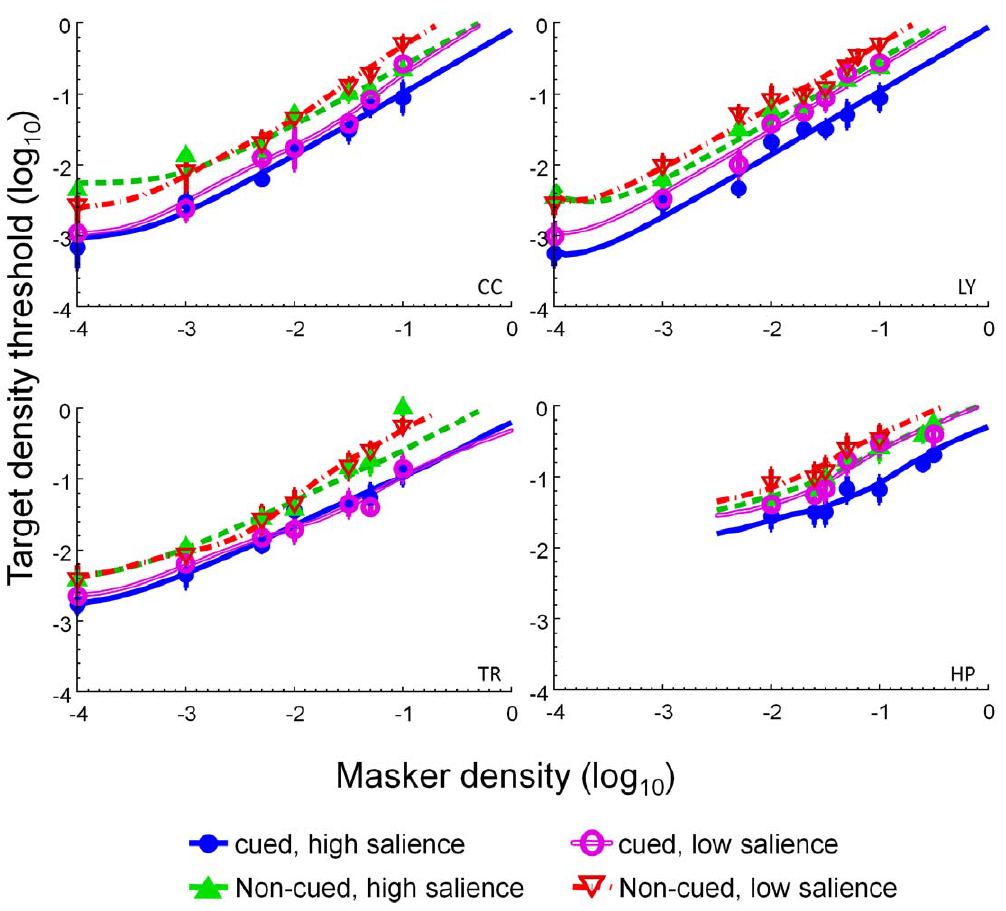
Figure 2. Target threshold vs. masker density functions. Each panel represents data from one observer. Blue denotes the TvD function for the cued high salience condition; magenta, the cued low salience condition; green, the non-cued high salience condition; and red, the non-cued low salience condition. The smooth curves are fits of the model discussed below. The error bars are the estimated standard error of measurement.